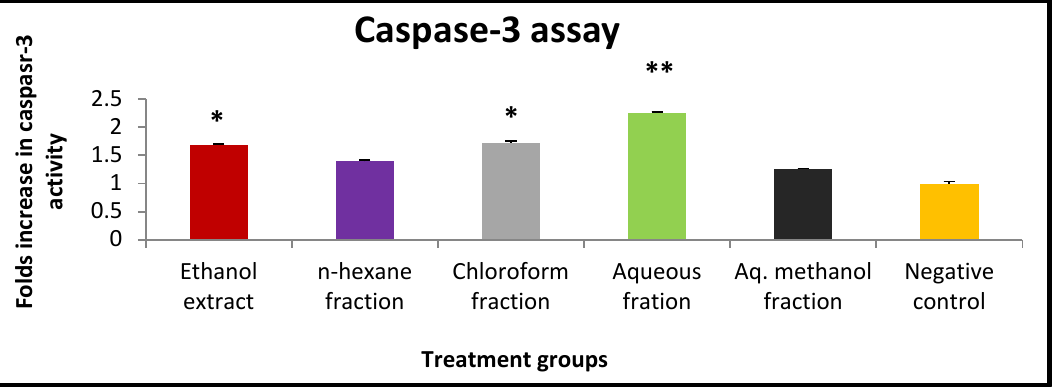
Figure 2. The effect of IC 50 concentration of X. spinosum extract and fraction on caspase -3 expression in EMT6/P cell line. The concentration of the extract and fractions: ethanol (2.5 mg mL − 1 ), chloroform (7.5 mg mL − 1 ), aqueous (11 mg mL − 1 ), aqueous methanol (8.1 mg mL − 1 ), and n -hexane (5.5 mg mL − 1 ).